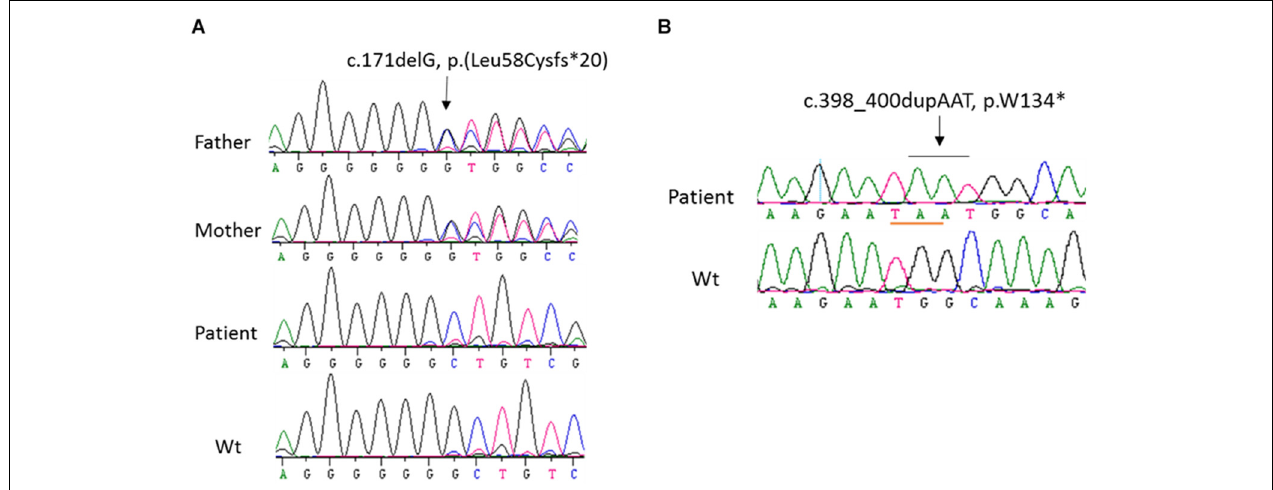
FIGURE 1 | Sequence analysis of CYP27B1 mutations. (A) A novel homozygous deletion of one nucleotide in the CYP27B1 gene in patient 10 from family 7. The mutation results in frameshift and a pre-matured stop codon 20 nucleotides from the deletion. His parents carry a heterozygous mutation. (B) A novel homozygous duplication of AAT in the CYP27B1 gene in patient 11 from family 10. The mutation creates a stop codon (highlighted in pink).